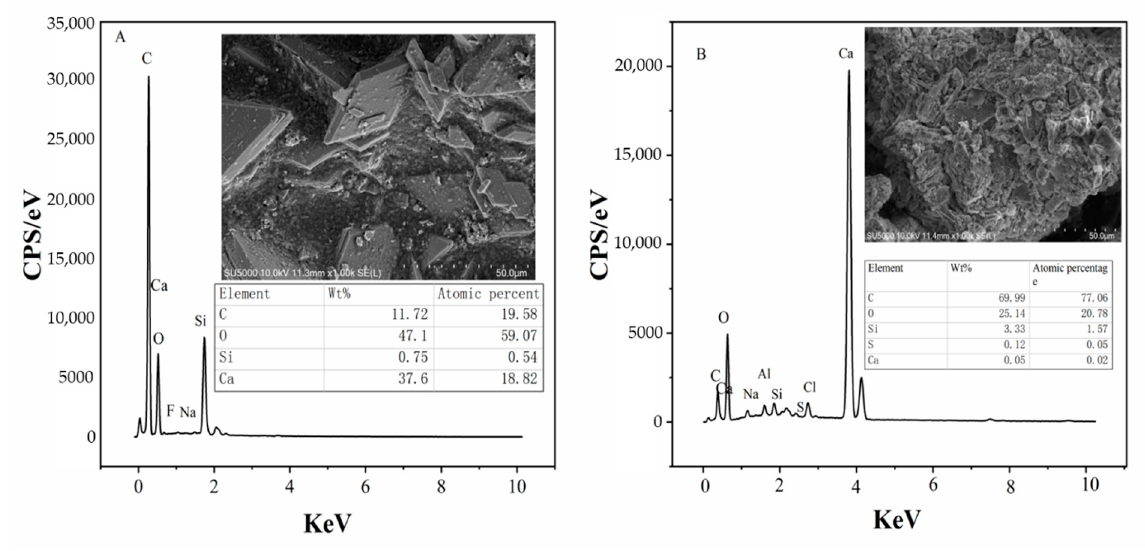
Figure 1. SEM-EDS of raw materials (A-PG, B-CCS).